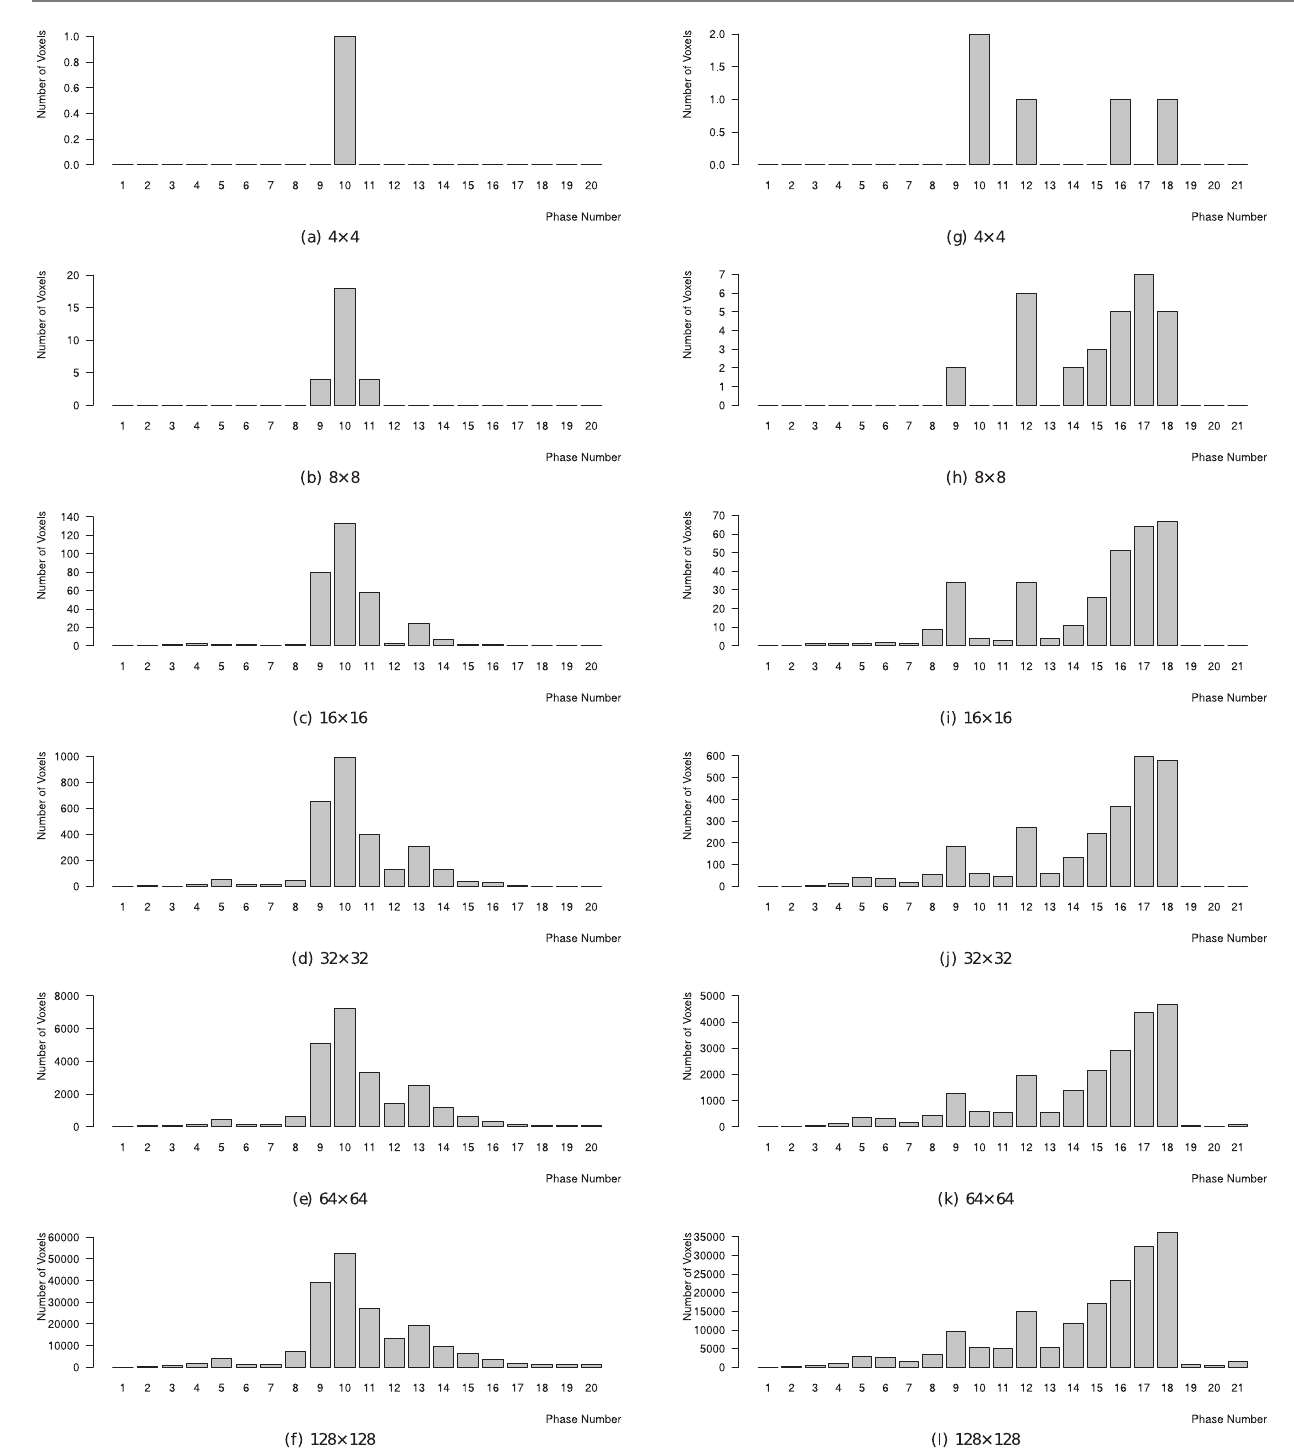
Fig. 4. Example of phase histograms for two patients with different matrix sizes. The reference phases for the first patient (a–f) were number 9 and 10. The algorithm always detected phase number 10, in agreement with the two readers. The reference phases for the second patient (g–l) were number 16–18. The algorithm detected a wrong phase (10) for the 4 6 4 matrix size (g) and phase number 17 or 18 for all other matrix sizes, which agreed with the readers. The decision for the matrix size of 8 6 8 (h) was very tight, because the detected and matched phase number 17 counted only one voxel more than the non- agreed number 12. Accordingly, a matrix size of 16 6 16 is